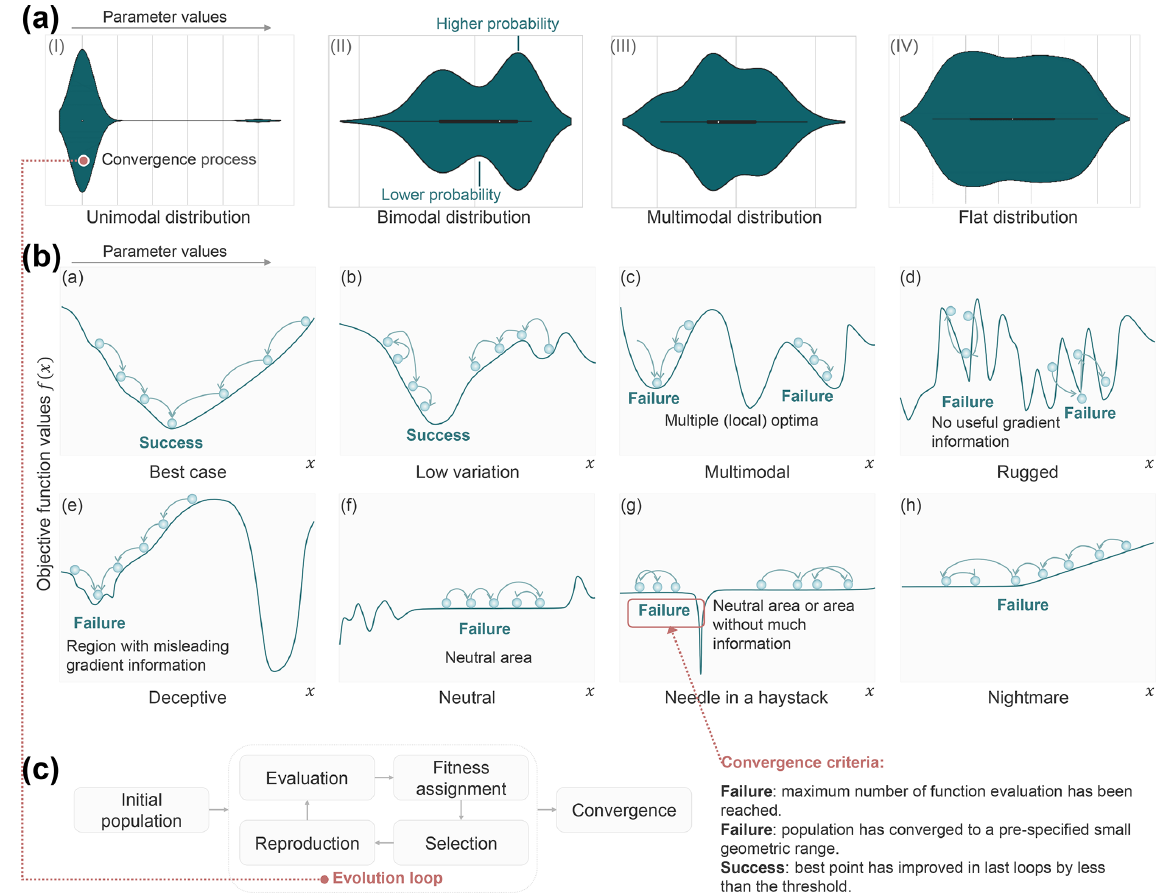
Figure 7. Evaluation of the ability of the dynamic parameters to respond to the catchment dynamics. (a) Evaluation of the convergence processes using violin plots (ECP-VP). The horizontal axis of the violin plot denotes the parameter values, and the vertical axis denotes the probability values. The probability distribution of elements of the search space is represented by the violin plots. (b) All possible properties of the fitness landscapes. (c) The basic cycle of the global evolution algorithm. Initial population: create an initial population of random individual. Evaluation: compute the objective values of the solution candidates. Fitness assignment: use the objective values to determine the fitness values. Selection: select the fittest individuals for reproduction. Reproduction: create new individuals from the mating pool by crossover and mutation. Note that the fitness landscapes are a very powerful metaphor for visualizing the convergence processes in global optimization. Some intuitive sketches of fitness landscapes with possible properties are as follows. The horizontal axis denotes the parameter values, and the vertical axis denotes the objective function values. The direction of the arrow represents the direction of evolution. The possible properties include the following. (a) Best case: an optimization process is ideal for estimating the globally optimal parameters. (b) Low variation: an optimization process with low variation is fair for estimating the globally optimal parameters. (c) Premature convergence: an optimization process has prematurely converged to a local optimum if it is no longer able to explore other parts of the search space than the area currently being examined and there exists another region that contains a superior solution. (d) Ruggedness: if the objective function values are fluctuating, i.e., increasing or decreasing, it is difficult to determine the correct direction for the optimization process. In short, ruggedness is multimodality plus steep ascends and descends in the fitness landscape. (e) Deceptiveness: the gradient of the deceptive objective function values leads the optimizer away from the optima. (f) Neutrality: the outcome of the application of a search operation to an element of the search space is neutral if it yields no change in the objective function values. (g) Needle in a haystack: the optimum occurs as an isolated spike in a plane, representing the occurrences of extreme ruggedness combined with a general lack of information in the fitness landscape. (h) Nightmare: the optimum is difficult to achieve in an approximate plane. More details on the fitness landscapes and their properties can be found in Weise